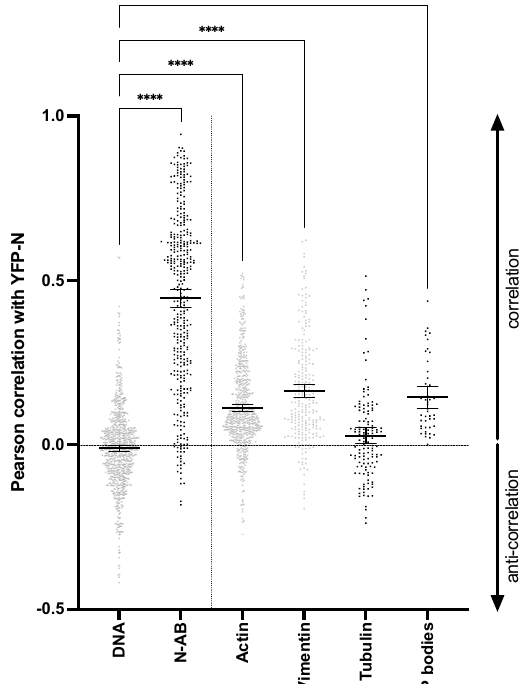
Figure 4. Quantitative automated image analysis reveals association of YFP-N with actin filaments, vimentin, and P-bodies but not tubulin. Micrographs as shown in Figures 1–3 were subjected to automated image analysis using cell profiler. Image segmentation examples are shown in the SI (Figure S4) and described in detail in the material and methods section. Bars show Pearson correlation of YFP-N with the markers as stated. Dots show individual cells ( n > 20). DNA staining is utilized as a negative control staining assuming negligible YFP-N expression in the nucleus. N protein antibody staining (N-AB) was employed as a positive control. All bars show mean with SEM. Significance was tested using a one-way analysis of variance (ANOVA), **** p ≤